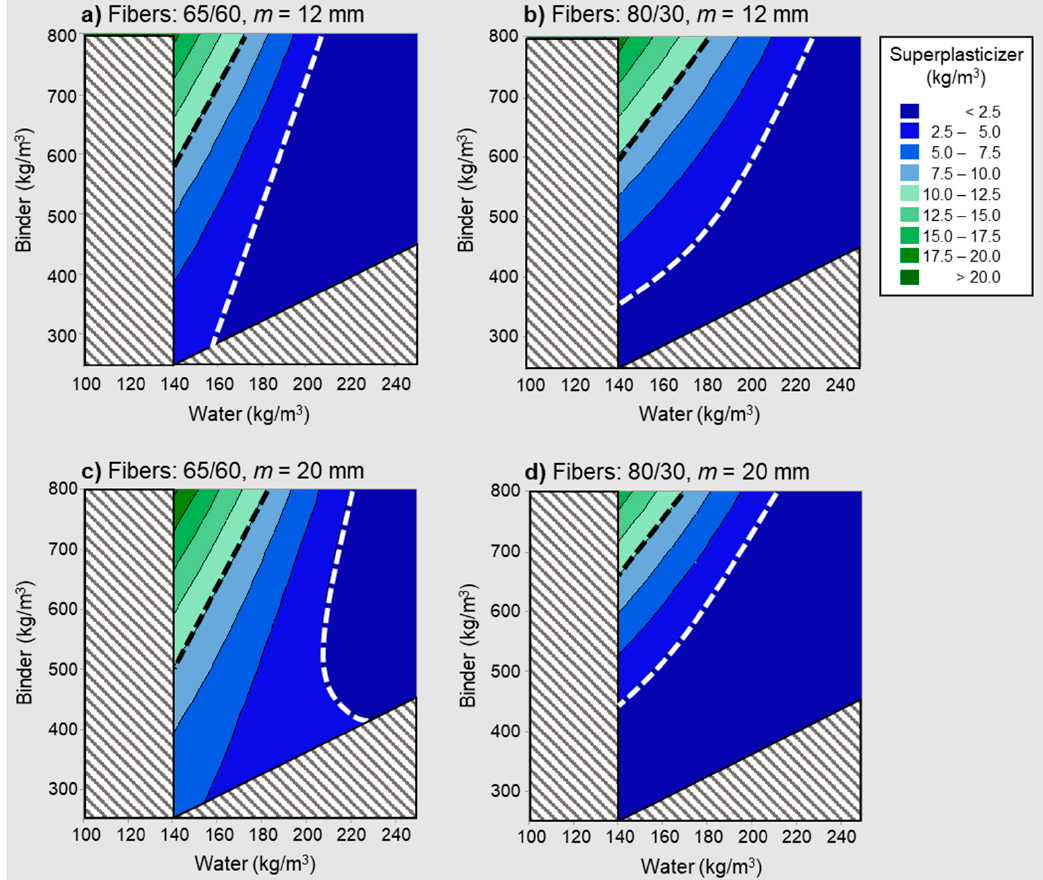
Figure 7. Superplasticizer content against water and binder contents. The greyed-out areas correspond to unusual water and binder content combinations, based on the representative ranges in Table 2: water contents out of the 140–237 kg/m 3 range and water-to-binder ratios out of the 0.2–0.6 range. Also, two particularly relevant contour lines are highlighted. The dashed white line represents a superplasticizer content of 2.5 kg/m 3 , which, to the right-hand side, defines a region corresponding to cases generally associated with low or no superplasticizer contents (colored in dark blue). Since the margin of error for the estimation of superplasticizer content as per Equation (6) was 3.7 kg/m 3 , estimates of 2.5 kg/m 3 or below were not necessarily different from zero. On the other hand, the dashed black line represents an estimated superplasticizer content of 10 kg/m 3 , which, to the left-hand side, defines a region corresponding to cases associated with high superplasticizer content (colored in green in Figure 7).